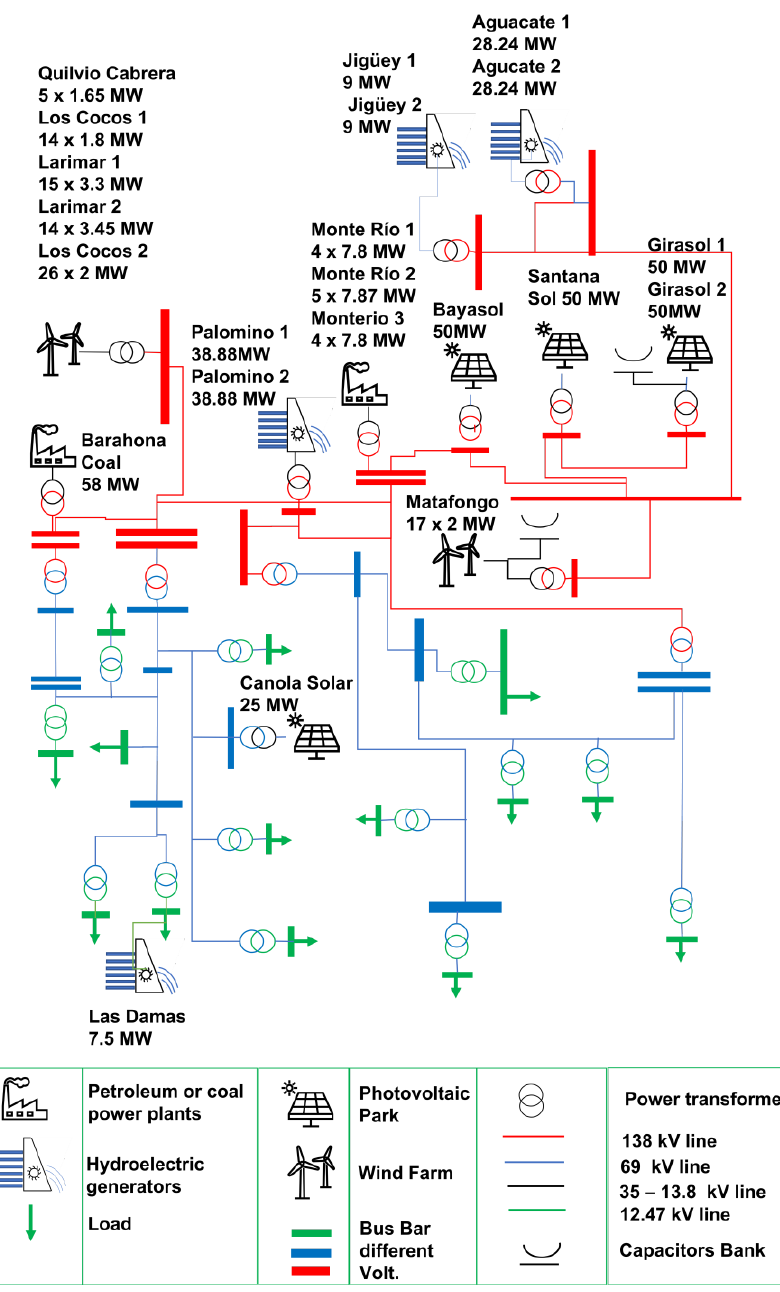
Figure 4. Grid section of the southern zone.